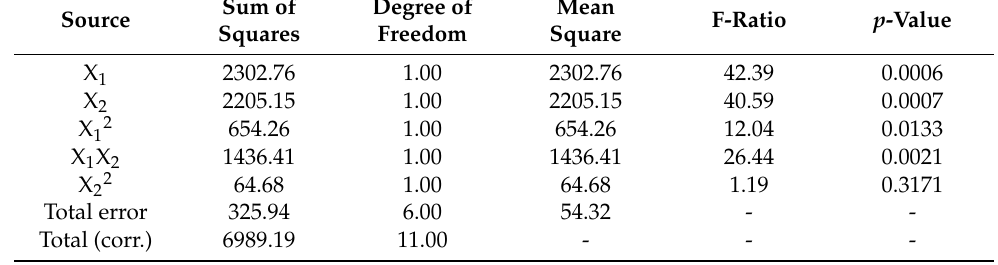
Table 2. Analysis of variance (ANOVA) of the response surface quadratic model.